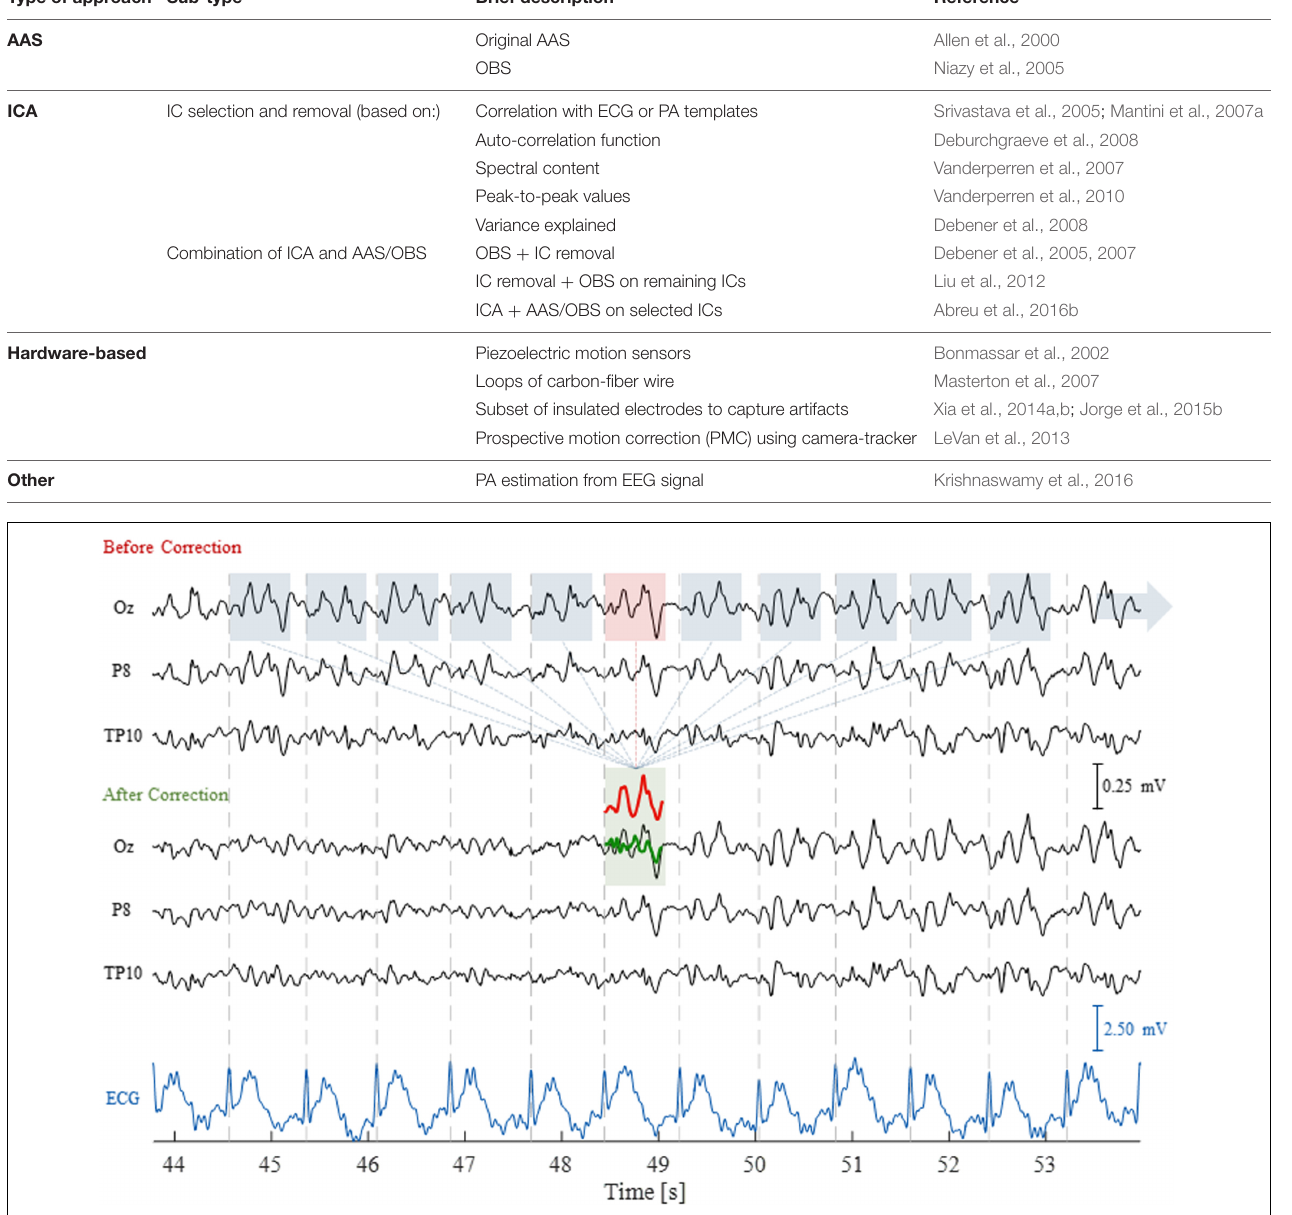
FIGURE 3 | Illustration of the AAS technique to correct for the pulse artifact (PA). The EEG traces are shown for three channels, before and after correction, as well as for the ECG channel, over a time period of 10 s including 11 artifact occurrences. The segmented windows for each artifact occurrence (blue and red boxes) were averaged to compute the artifact template (red trace); this was then subtracted from the corresponding artifact occurrence (red box), yielding the artifact-corrected signal (green